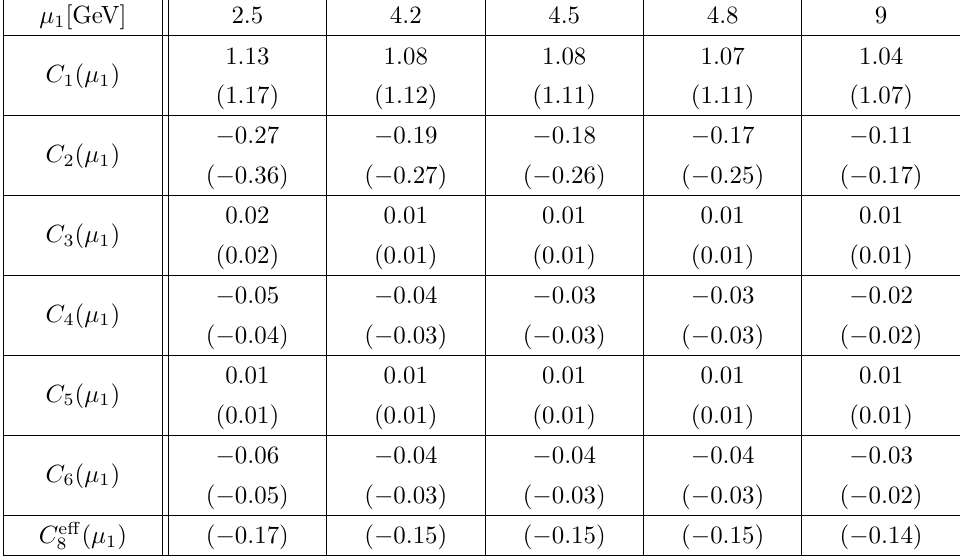
Table 8 . Values of the Wilson coefficients at NLO(LO)-QCD for different choices of µ 1 .